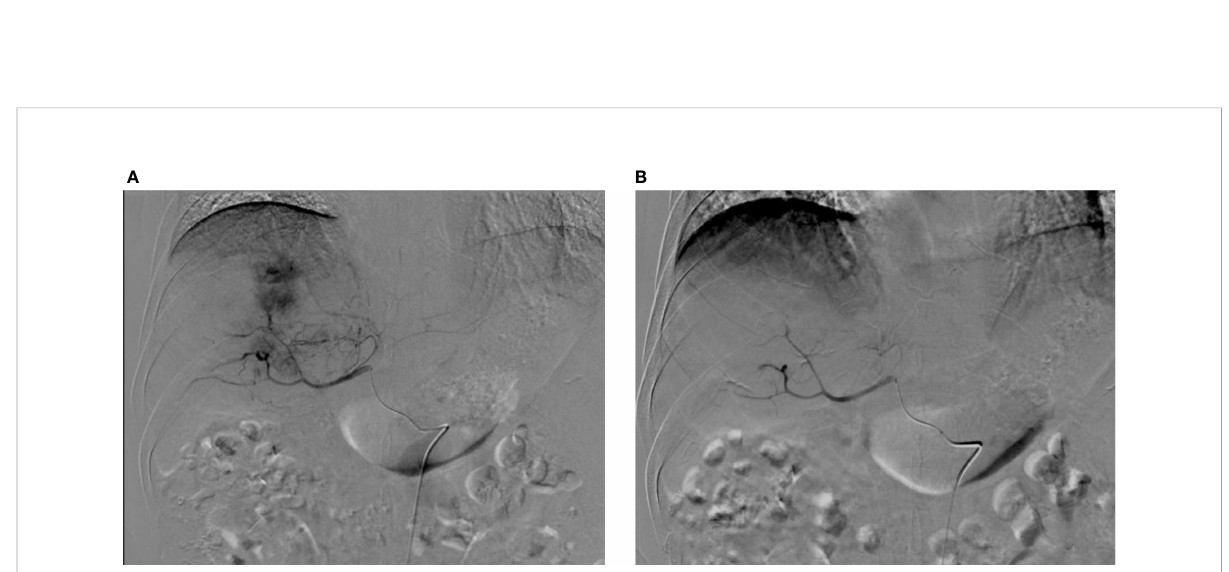
FIGURE 3 Digital subtraction angiography (DSA) before and after surgery. (A) DSA before CSM-TACE shows intrahepatic mass tumor staining, and the feeding arteries mainly come from the right hepatic artery; (B) After embolization with CSM particles, the target blood vessels were blocked, and postoperative DSA shows the tumor staining